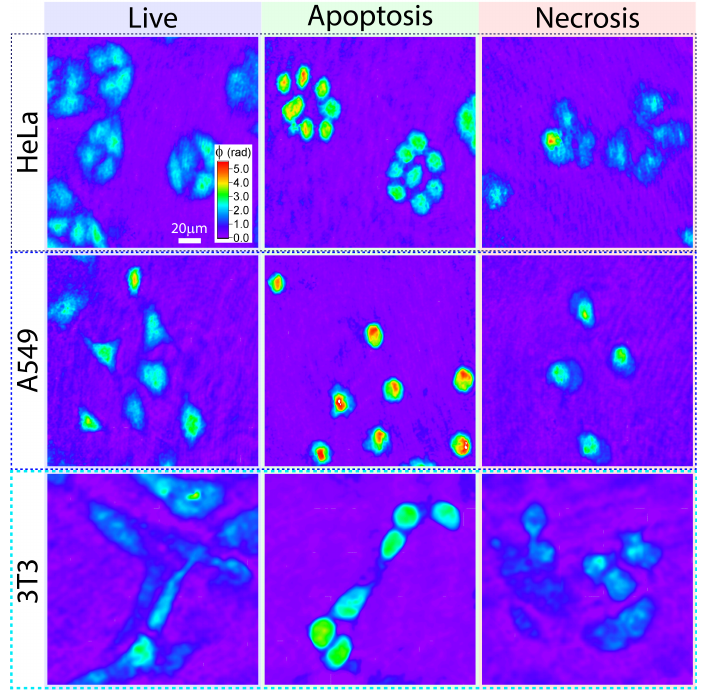
Figure 3. Examples of phase images of HeLa, A549 and 3T3 cells in three states: live, apoptotic and necrotic. An extended set of phase images of live HeLa, A549 and 3T3 cells is provided in Supplementary Materials for visual comparison of cells morphology. Table 1. Classification accuracy of states of HeLa, A549, and 3T3 cells, cell lines and states of cells among three cell lines using SVM (support vector machine), k-NN (k-nearest neighbors) and EC (ensemble classifier) machine-learning